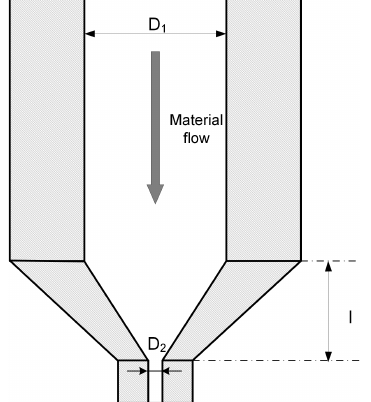
Figure 2. Key dimensions of the printing